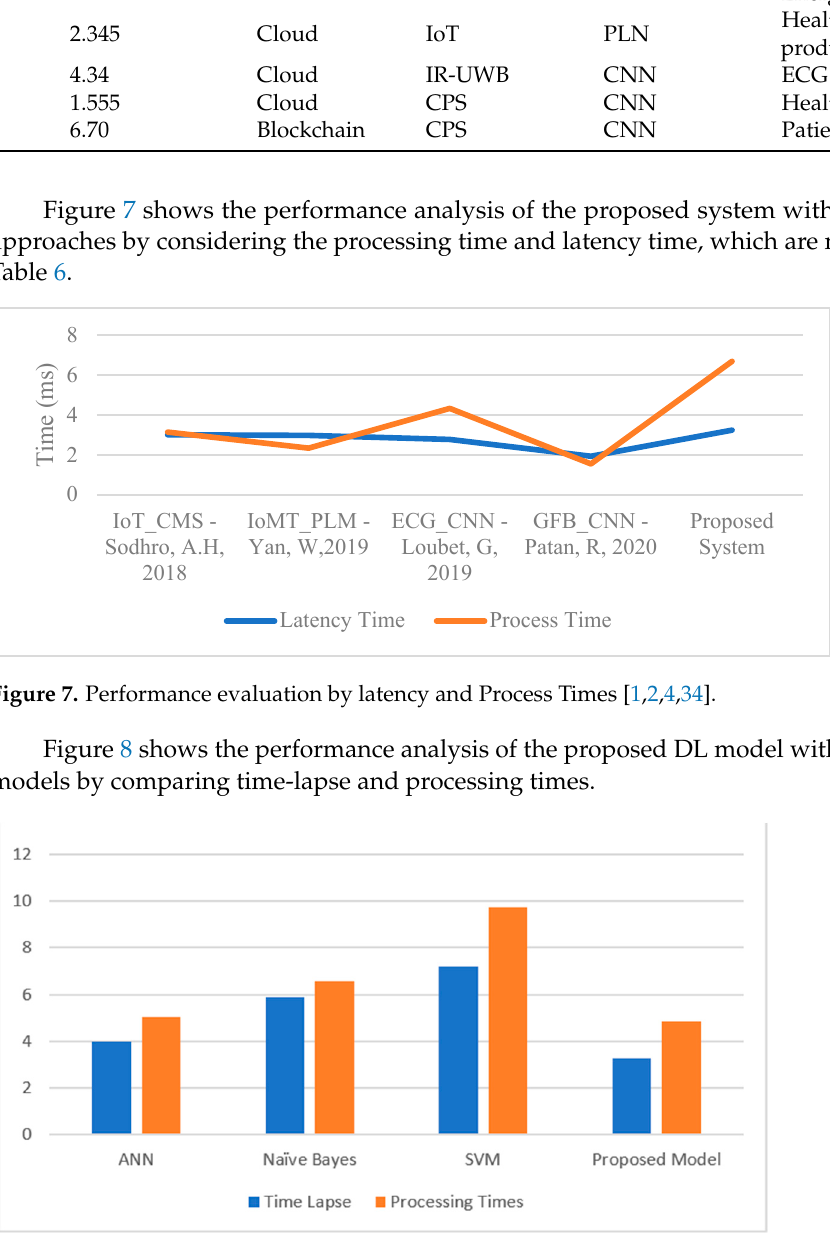
Figure 8. Performance evaluation of DL models by Time-lapse and Process Times.